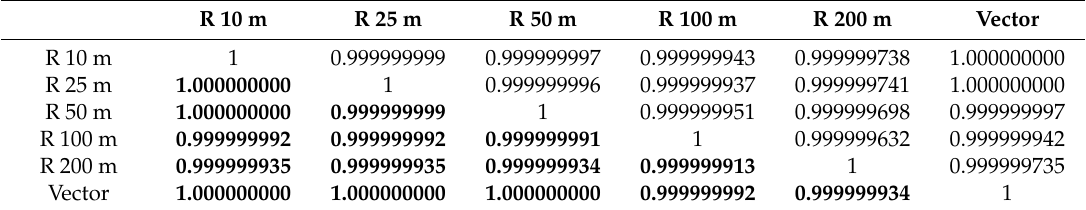
Table 8. Correlation coefficients between LUCC table transition areas with different resolutions (R) and vector data of CLC (bold values) and COS (significance level p < 0.05). R 10 m R 25 m R 50 m R 100 m R 200 m Vector R 10 m